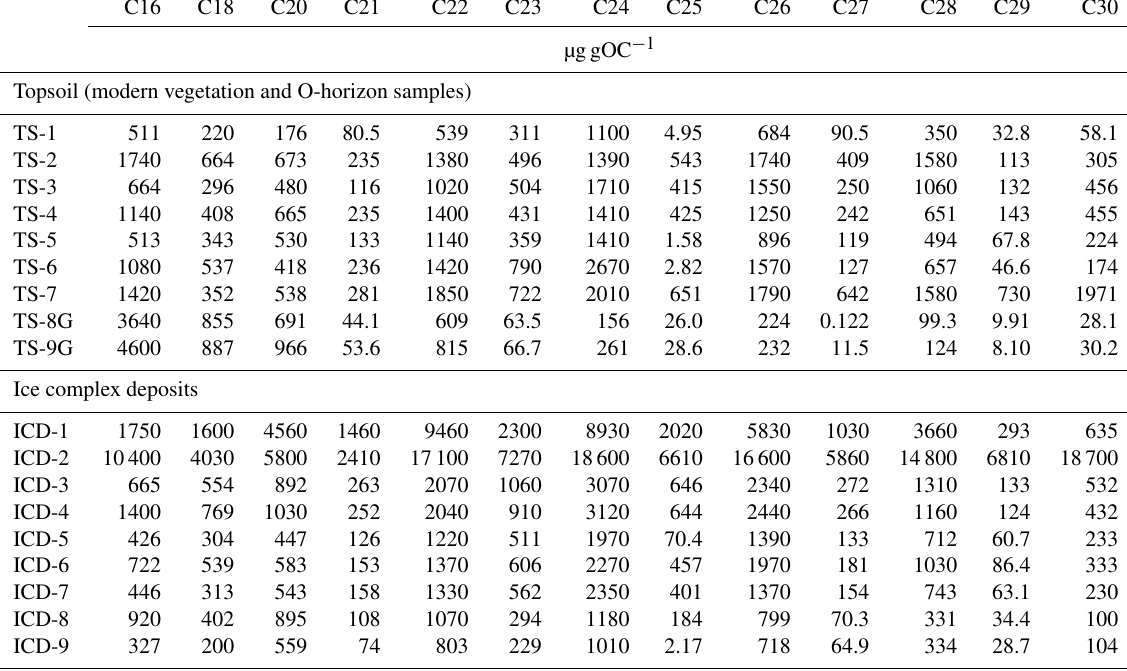
Table 3. Long-chain n -alkanoic acids concentrations (in µggOC − 1 ) of topsoil Holocene samples (modern vegetation and O horizon) and Pleistocene ice complex samples.